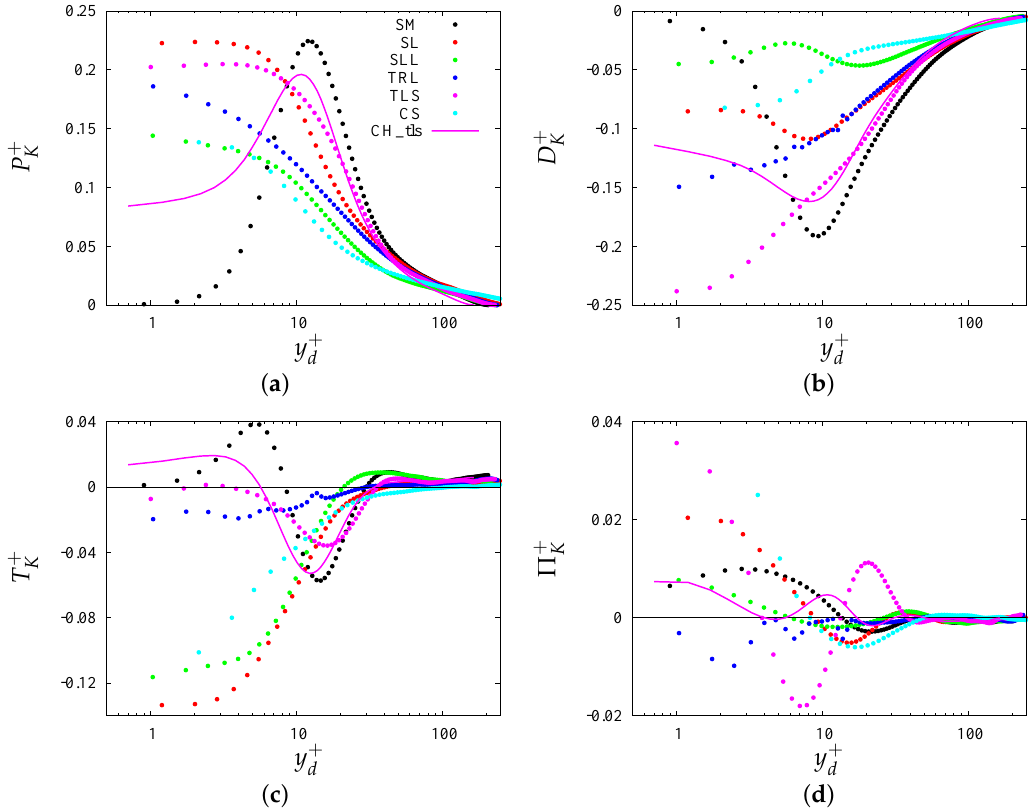
Figure 3. Terms in the turbulence kinetic energy budget (Equation (2)): ( a ) production ( P + ( c ) turbulent transport ( T + ), and ( d ) pressure transport ( Π + K refers to data for the TLS geometry in channel